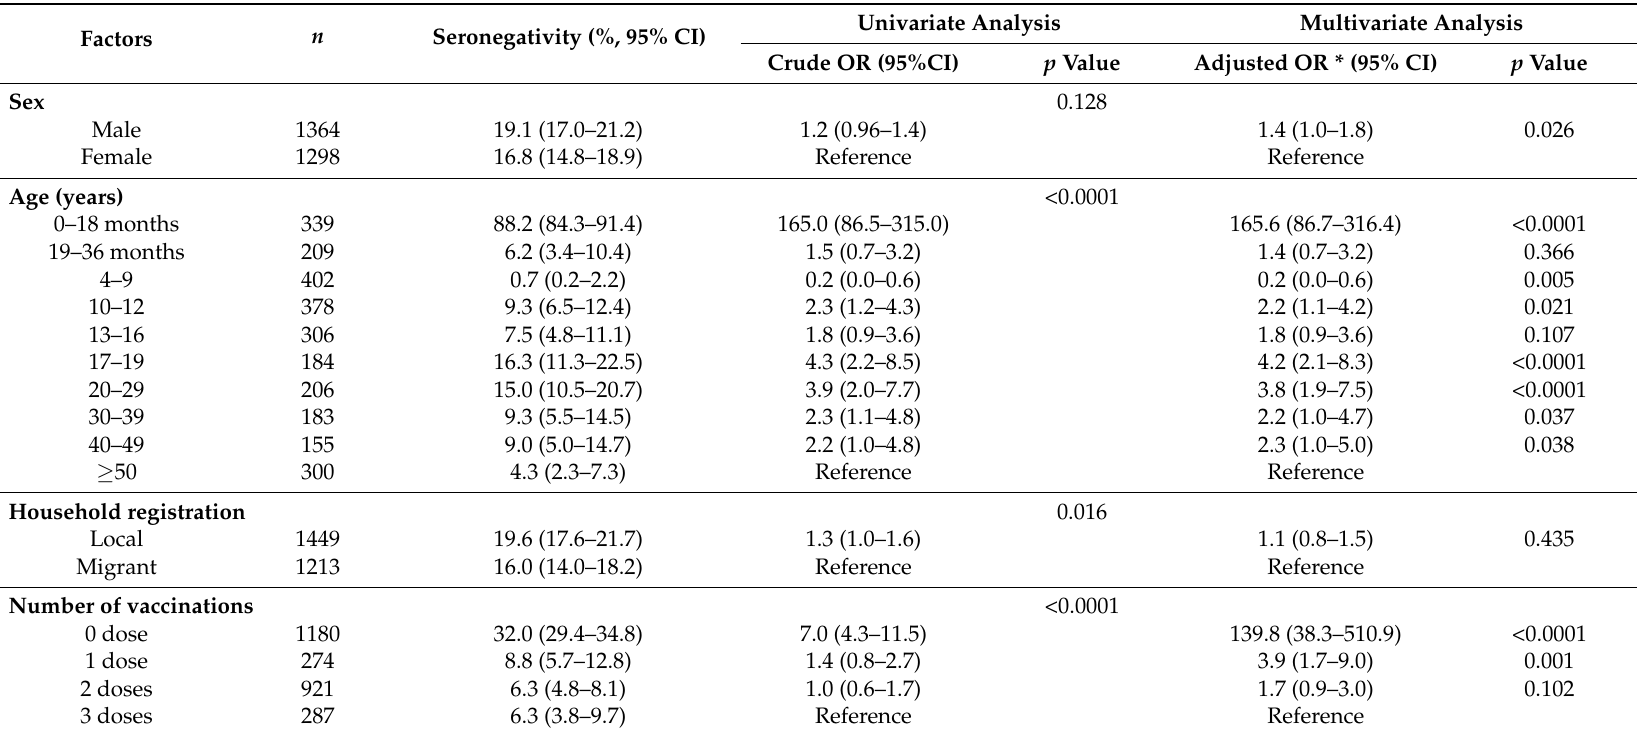
Table 2. Potential factors for seronegativity of mumps antibody with corresponding crude and adjusted odds ratios